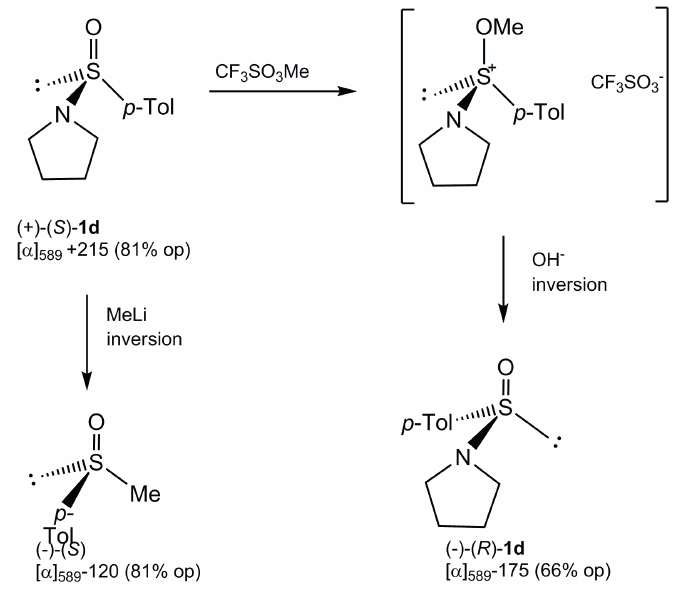
Scheme 8. Interconversion of the N - p -tolylsulfinylpyrrolidine ( 1d ) enantiomers. 2.3. Stereoselective Synthesis of Optically Active Sulfinates and Stereochemistry of Their